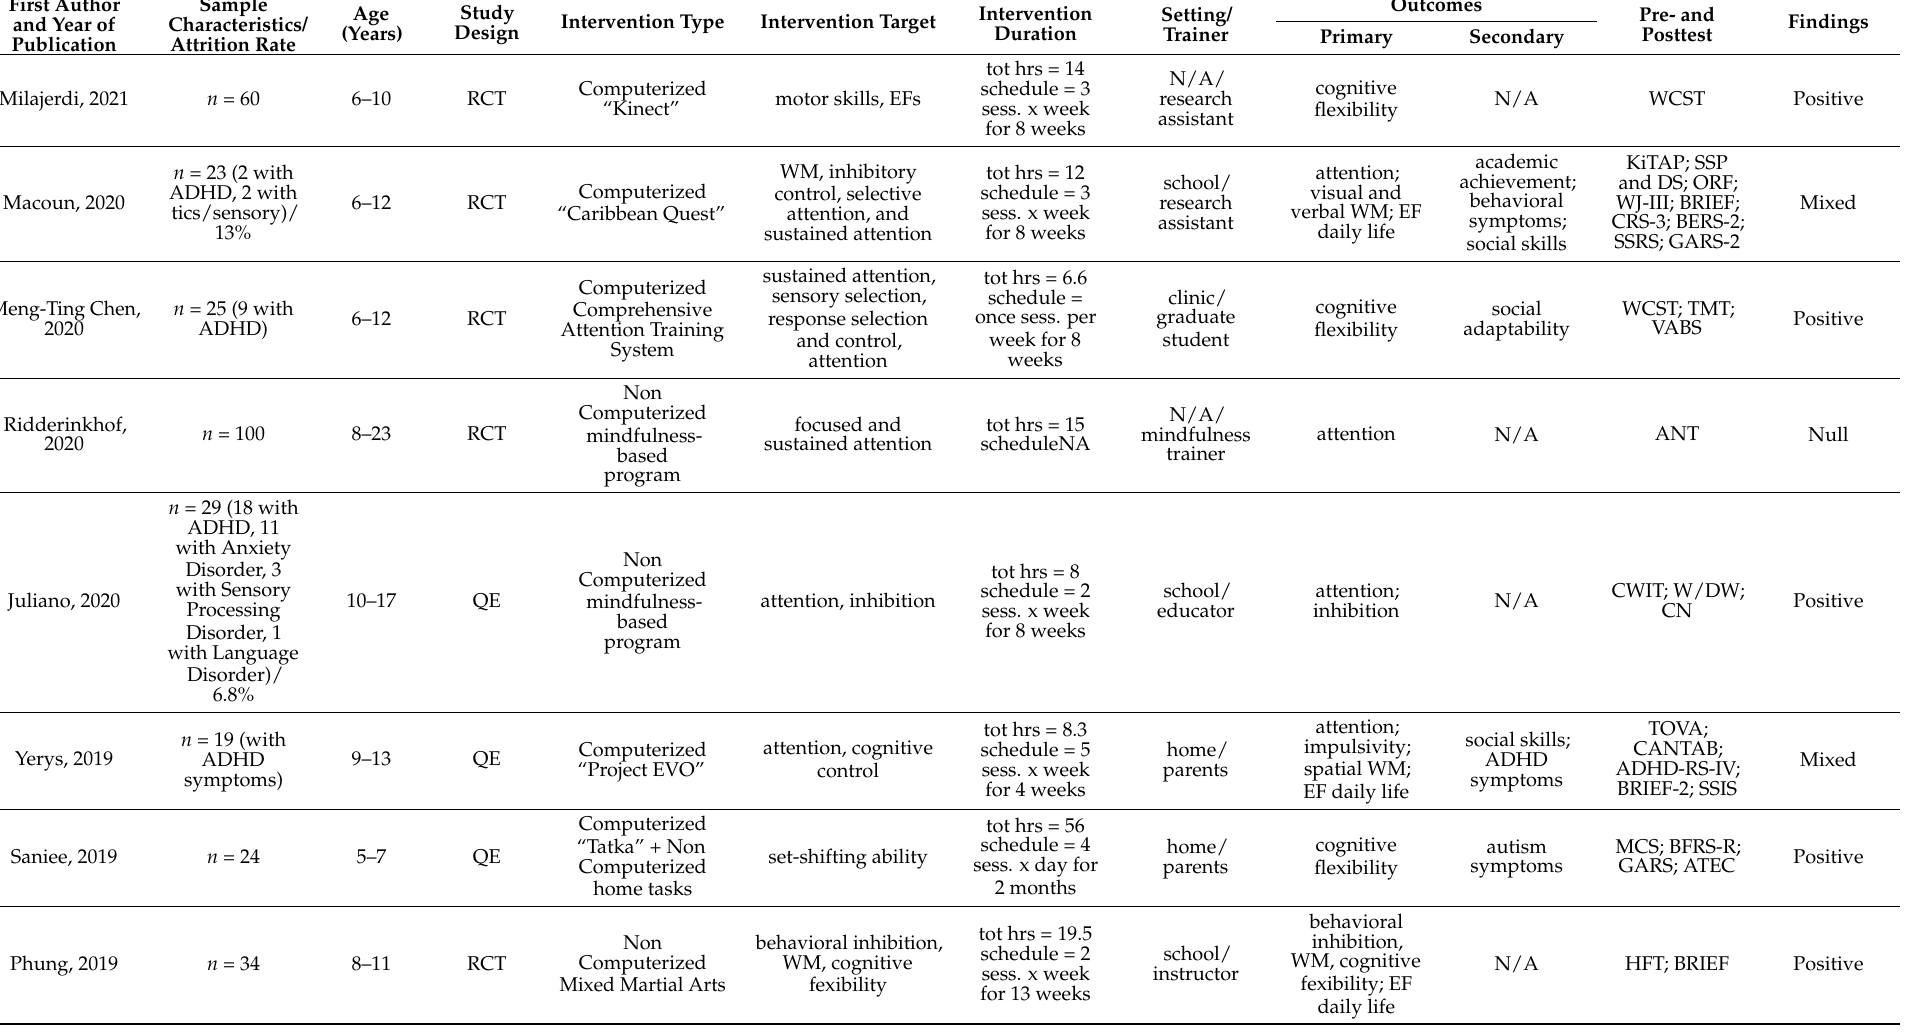
Table 2. Characteristics of the included